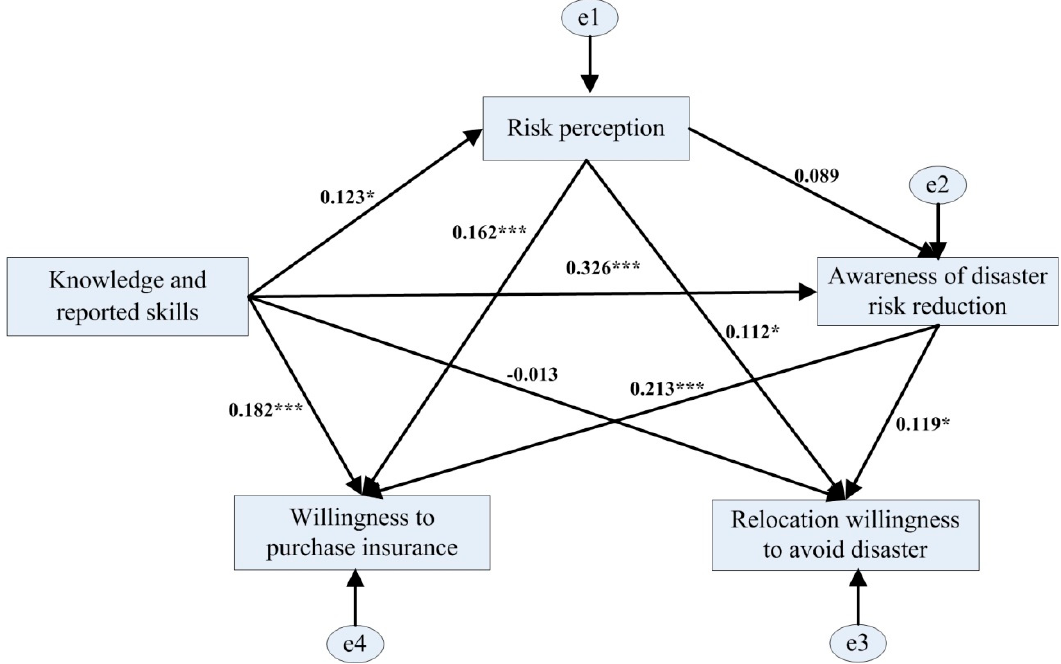
Figure 5. Path analysis results of the disaster risk perception model. Note: * and *** refer to p < 0.1 and p < 0.01, respectively.